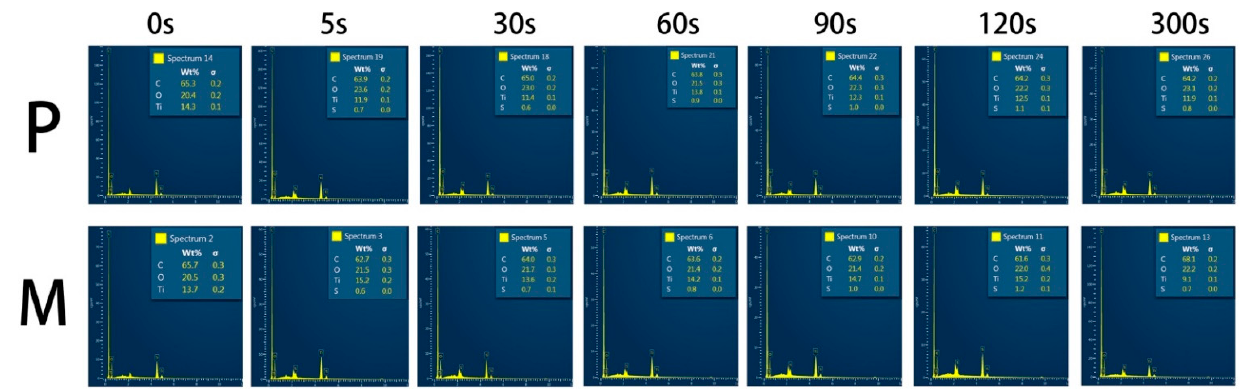
Figure 2. EDS spectrum of different sulfuric acid etching duration of the printed and milled PEEK specimens. P : etched printed PEEK; M : etched milled PEEK. EDS, energy-dispersive spectrometer.